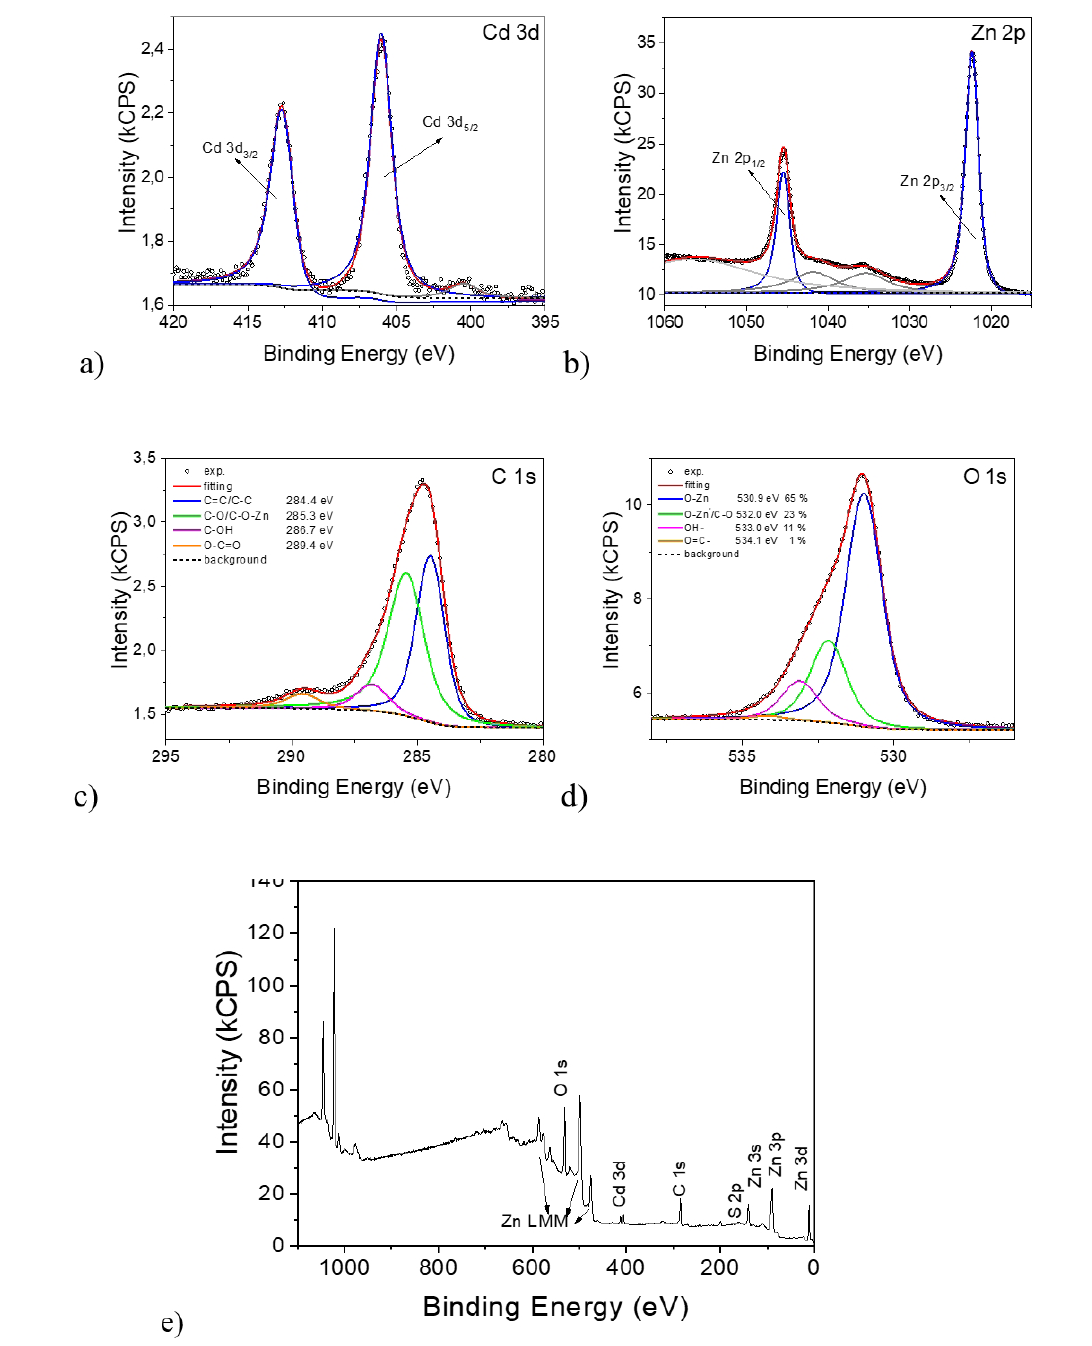
Cd S: a) Cd 3d; b) Zn 2p; c) C 1s; d) O 1s and e) Survey 0.5 0.5